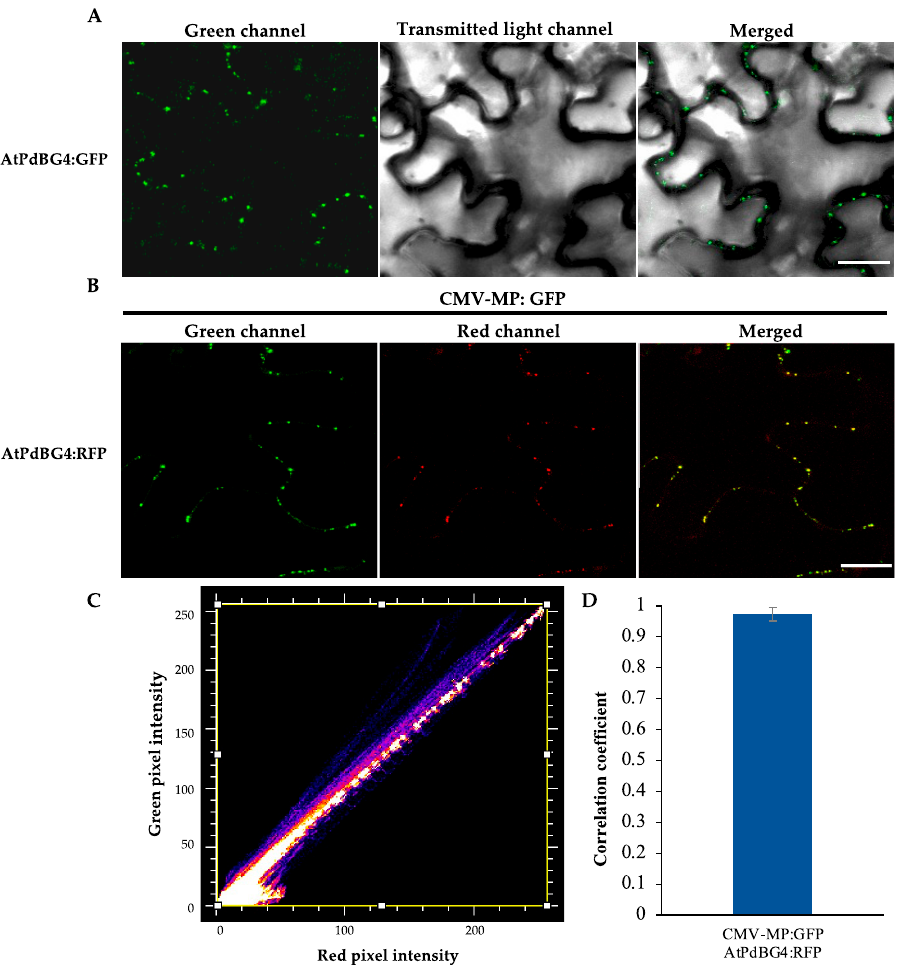
Figure 2. PdBG4 subcellular localization on PD. ( A ) Subcellular localization of AtPdBG4 fluorescence signal near the PD. ( B ) AtPdBG4 co-localized with the PD marker CMV MP-GFP. The C-terminal RFP-tagged AtPdBG4 was agroinfiltrated into the leaves of CMV MP-GFP transgenic N. tabacum plants. The yellow signal in the merged images represents the co-localization of AtPdBG4 with CMV MP-GFP. Images were obtained by CLSM. Bars = 20 µm. ( C ) Scatterplot of red and green pixel intensities of CMV MP-GFP and AtPdBG4:RFP. ( D ) Pearson correlation coefficient (PCC) of the images of green CMV MP-GFP and red AtPdBG4:RFP.